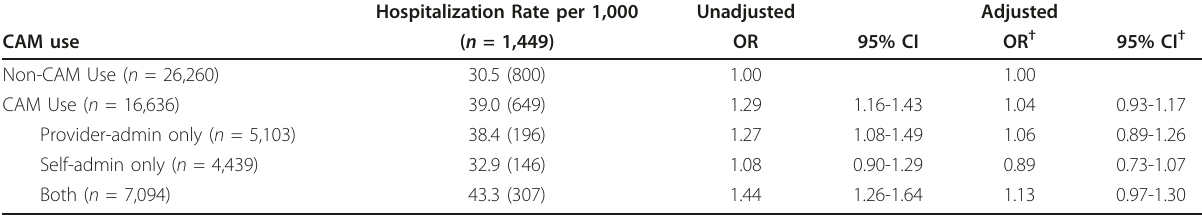
Table 3 First hospitalization rates by CAM use, unadjusted and adjusted odds ratios for active-duty military